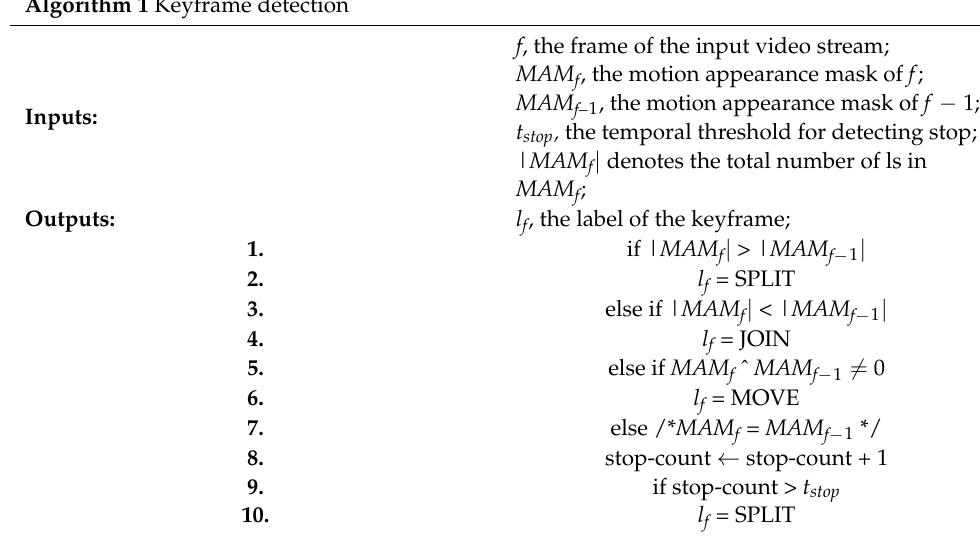
Algorithm 1 Keyframe